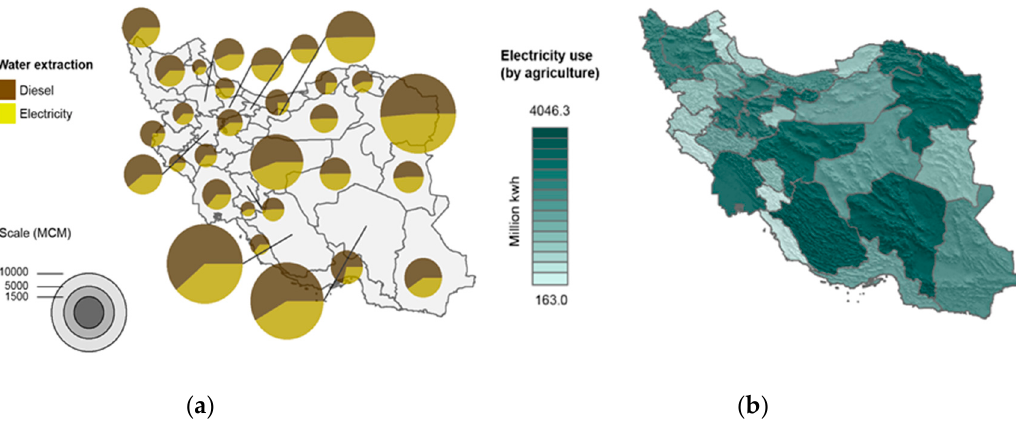
Figure 10. ( a ) Average groundwater withdrawal from electric and diesel irrigation wells from 2014 to 2016; ( b ) spatial distribution of electric energy consumption by province.